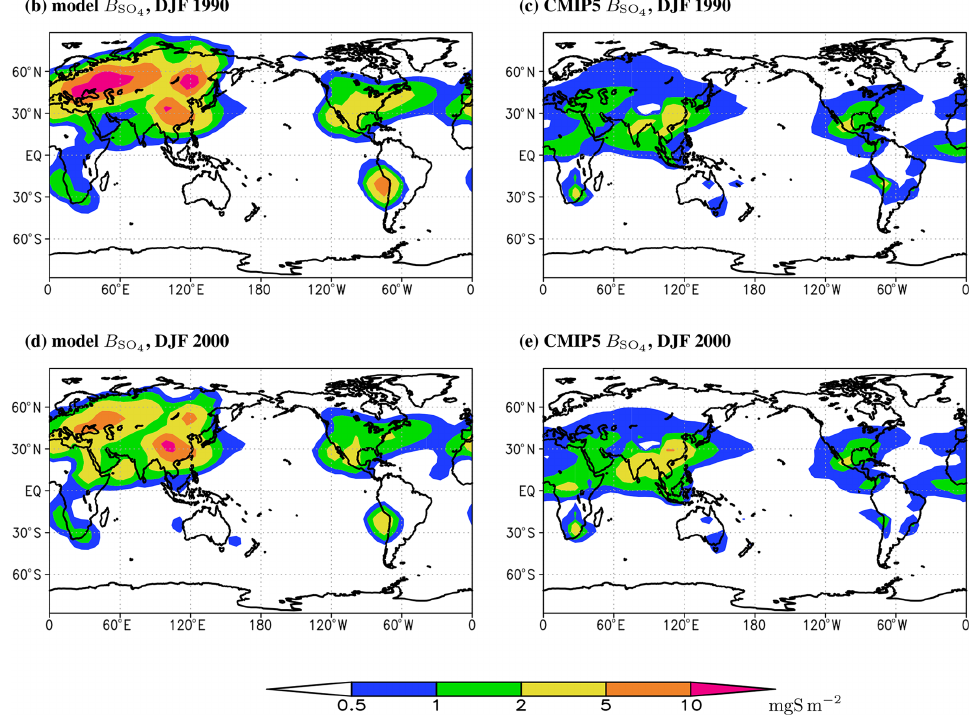
Figure 6. December–February mean sulfate burdens per unit area in the model (a, c) and in the CMIP5 database (b, d) in the years 1990 (a, b) and 2000 (c, d) .